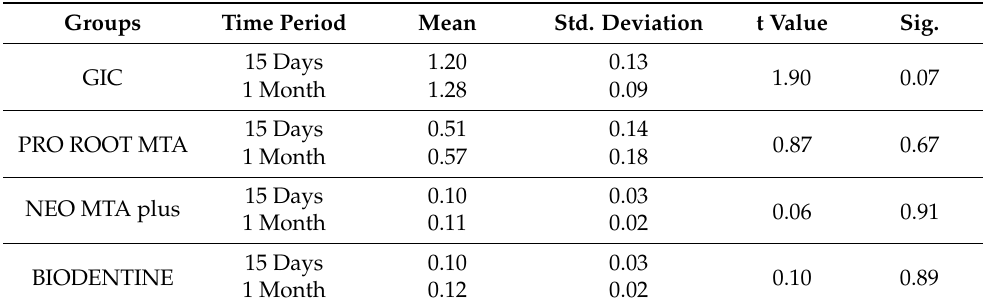
Table 4. Intergroup comparison of microleakage in GIC group between fifteen days and one month.